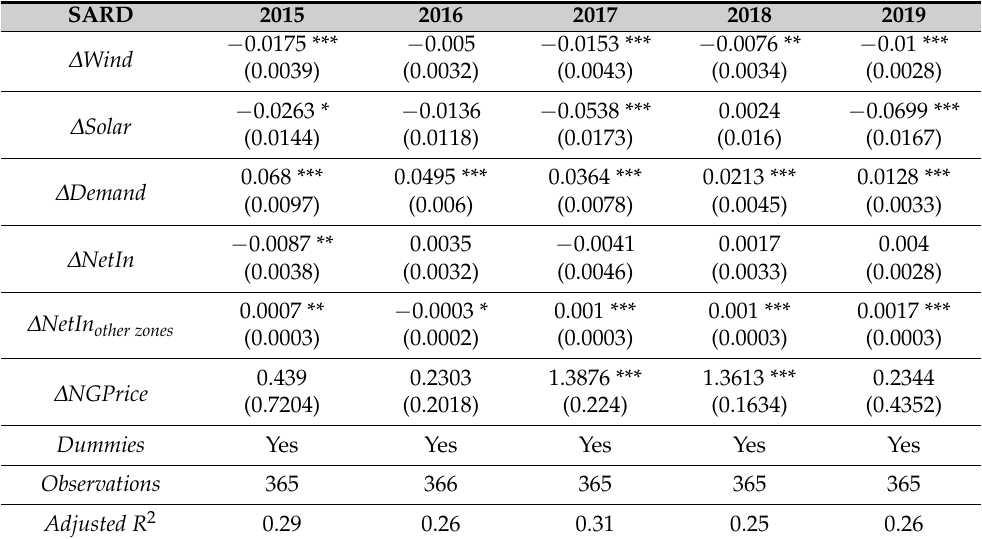
Table A16. OLS estimation of daily changes in electricity prices of SARD; results of Equation (3).